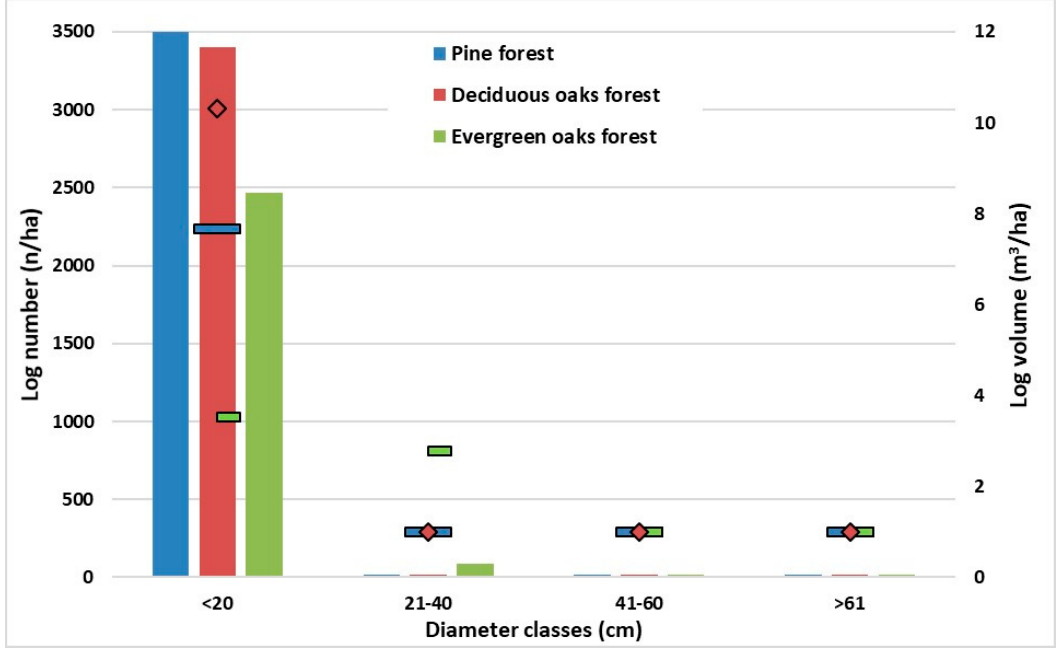
Figure 5. The histograms show the number of logs referred to as diametric (DBH) distribution in each forest type (left y-axis) . The scatter bars/polygon show the log volume referred to the diameter (DBH) distribution in each forest type (right y-axis).